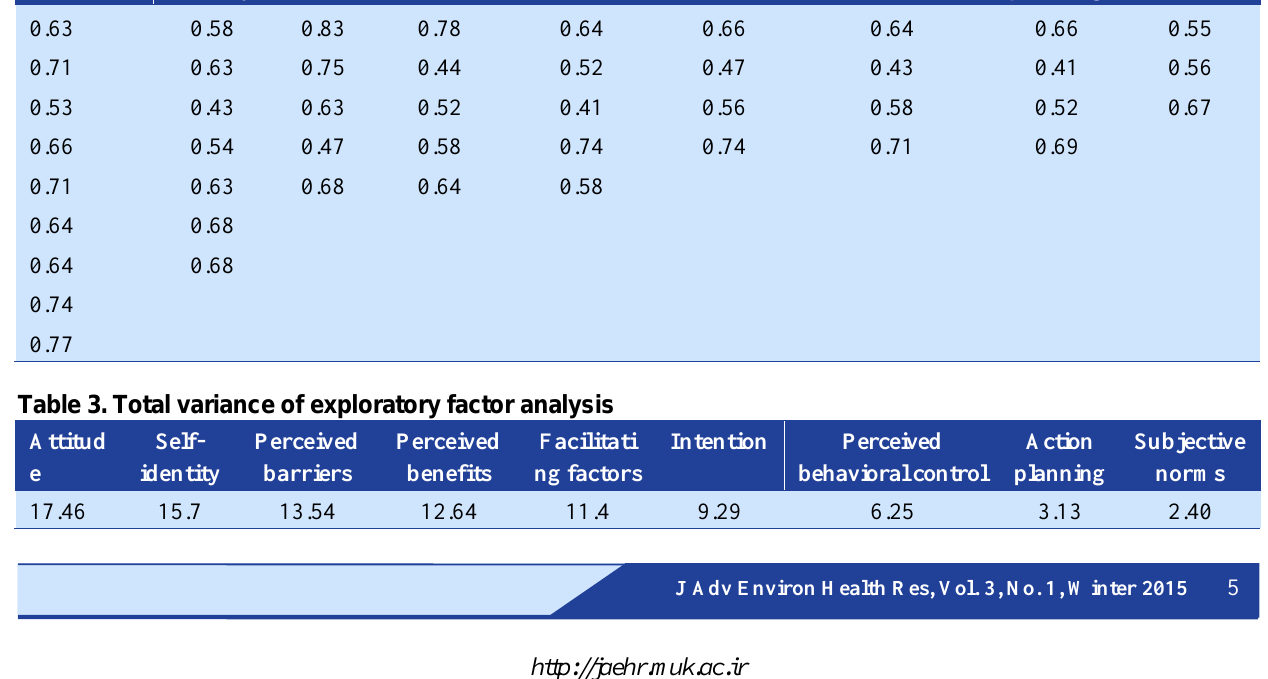
Table 2. Weight of factor extracted from the exploratory factor analysis with varimax rotation Perceived barriers